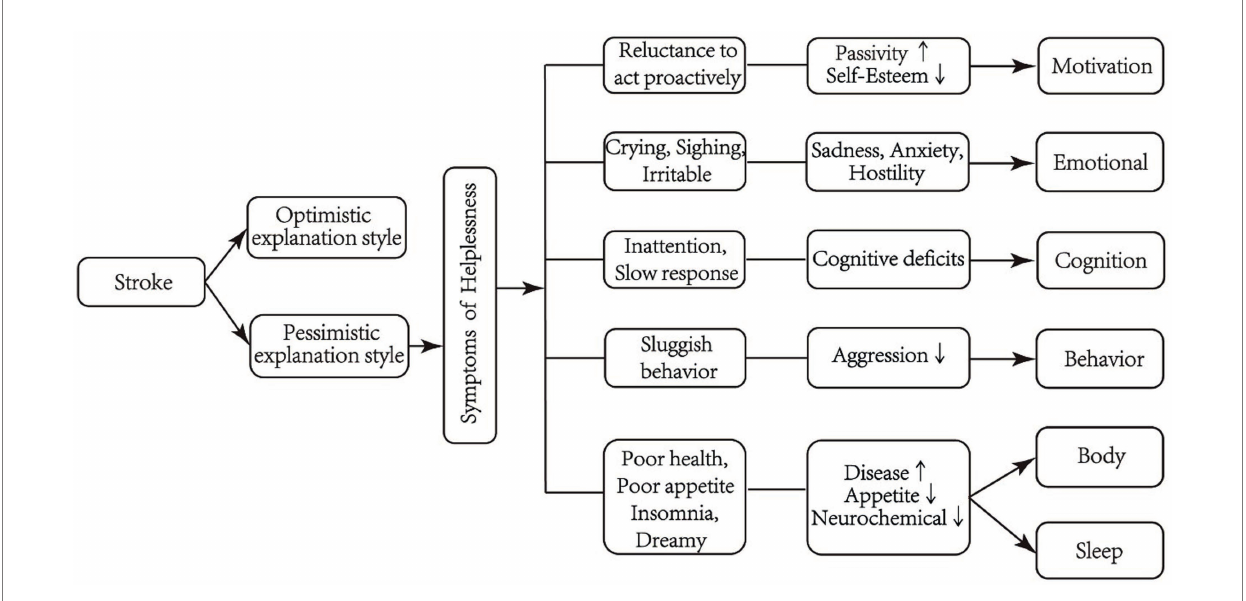
FIGURE 1 Conceptual